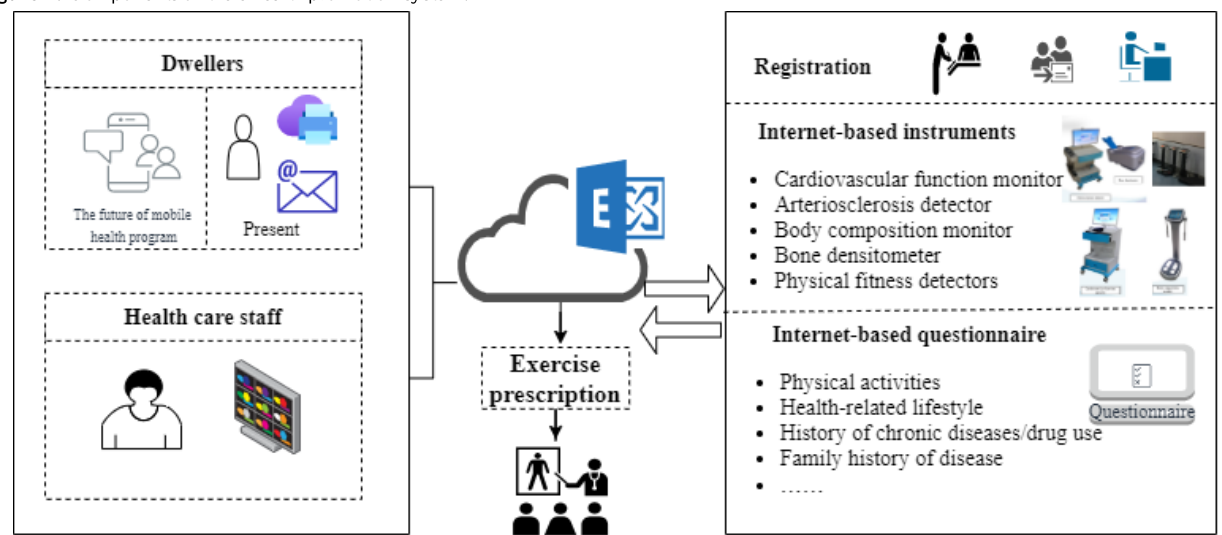
Figure 1. Components of the eHealth promotion